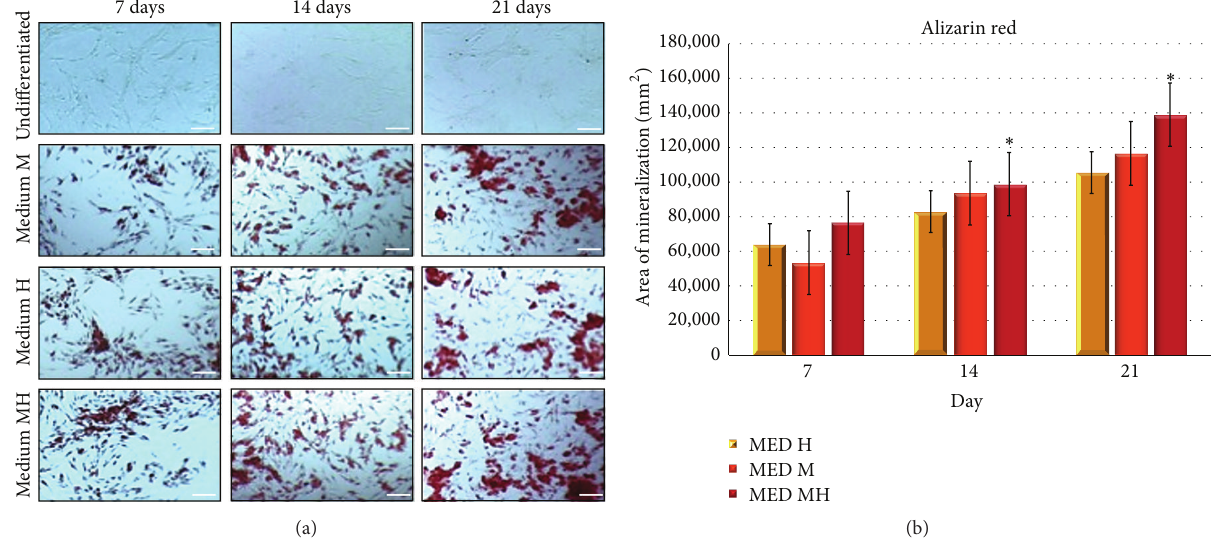
Figure 4: Alizarin red stain quantified by measurement of calcium deposits. (a) hDPSCs were cultured for 7, 14, or 21 days in the presence of one of the 3 conditioned media described under Materials and Methods and based on 0,01M melatonin (medium M) or a mixture of HA 2 mg/mL + BU 5mM + RA 1 𝜇 M (medium H) or on a combination of melatonin together with HA + BU + RA (medium MH) or kept under an undifferentiated state by growing on medium C. Scale bar = 200um. (b) Quantitative mineralization of hDPSCs cultured in maintenance medium (medium C) or the different osteogenic media (medium M, medium H, and medium MH). Results are expressed as mean + SD. An average was made from three technical replicates. Values represent the mean standard deviation of 4 different